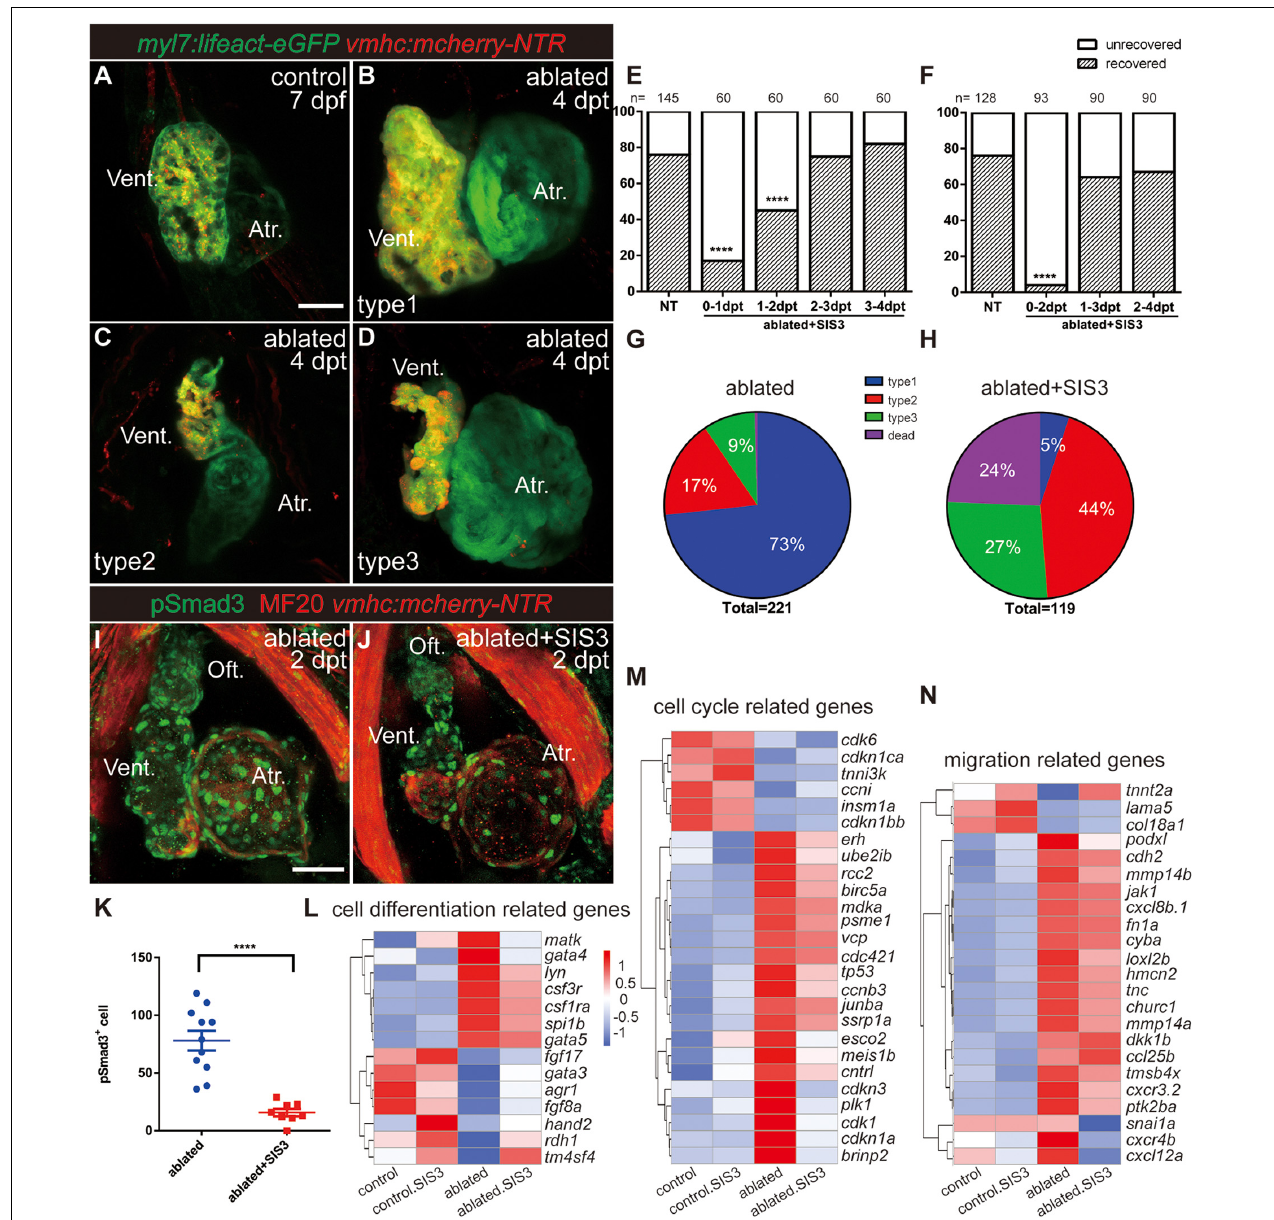
FIGURE 2 | Inhibition of TGF- β /Smad3 signaling pathway impedes ventricular regeneration. (A–D) Representative fluorescence images showing the morphology of control Tg(myl7:lifeact-eGFP; vmhc:mCherry-NTR) hearts (A) and three types of ablated hearts at 7 dpf/4 dpt, fully regenerated ventricle ( B , type 1), tiny ventricle ( C , type 2), and partially regenerated ventricle ( D , type 3). (E,F) Quantification of the heart regeneration ratio at 7 dpf/4 dpt in the ablated larvae with different length of SIS3 treatment. The numbers of larvae analyzed for each condition are indicated above the chart. Chi-square test, **** P < 0.0001. (G,H) Pie charts show cardiac morphology classification in the ablated larvae without (G) or with a 48-h SIS3 treatment (H) at 4 dpt. N = 221 and 119, respectively. (I,J) Representative immunostaining images of Tg(vmhc:mCherry-NTR) hearts showing that phospho-Smad3 signal was decreased in the ablated hearts at 5 dpf/2 dpt upon a 48-h SIS3 treatment (J) . Green, anti-pSmad3; red, MF20 (anti-MHC). (K) Quantification of phospho-Smad3-positive cells in the ablated hearts without or with a 48-h SIS3 treatment at 5 dpf/2 dpt ( N = 11 and 8, respectively). Mean ± s.e.m., Student’s t -test, two-tailed, **** P < 0.0001. (L–N) Transcriptomic analysis revealed differentially expressed genes involved in cell differentiation, cell cycle, and migration. Scale bars, 50 µ m. dpf, days post-fertilization; dpt, days post-treatment; atr., atrium; oft., out flow tract; vent., ventricle.